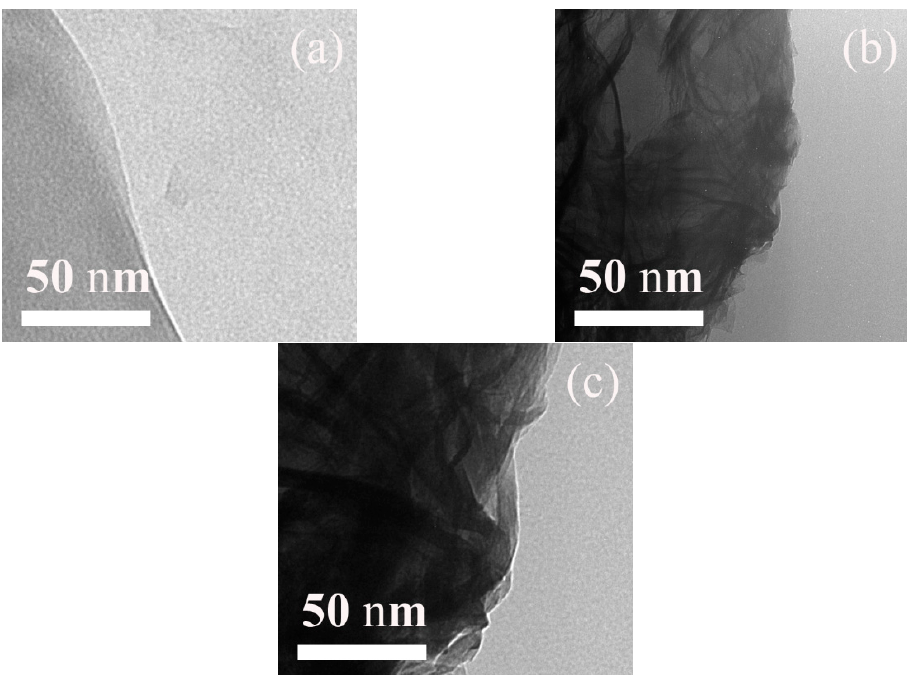
Figure 1. TEM images of unmodified GO ( a ), GO-PHEMATMS − 1 ( b ), and GO-PHEMATMS-2 ( c ) particles.